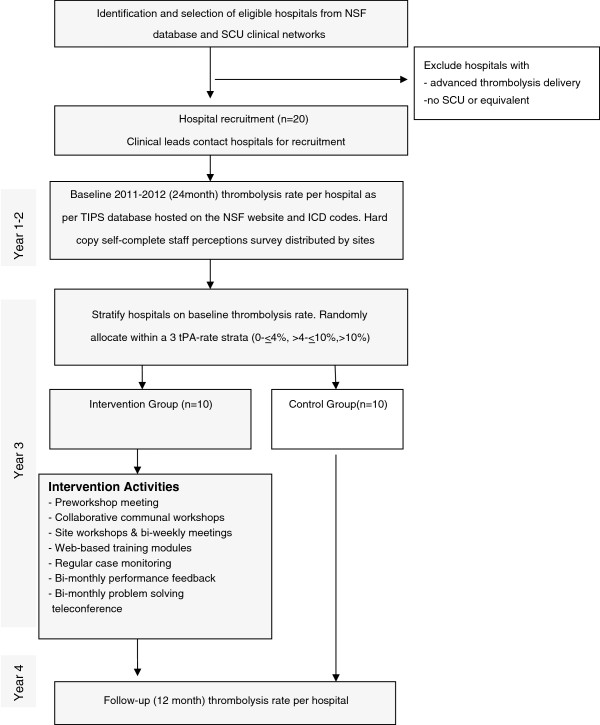
Study design & timeframe.